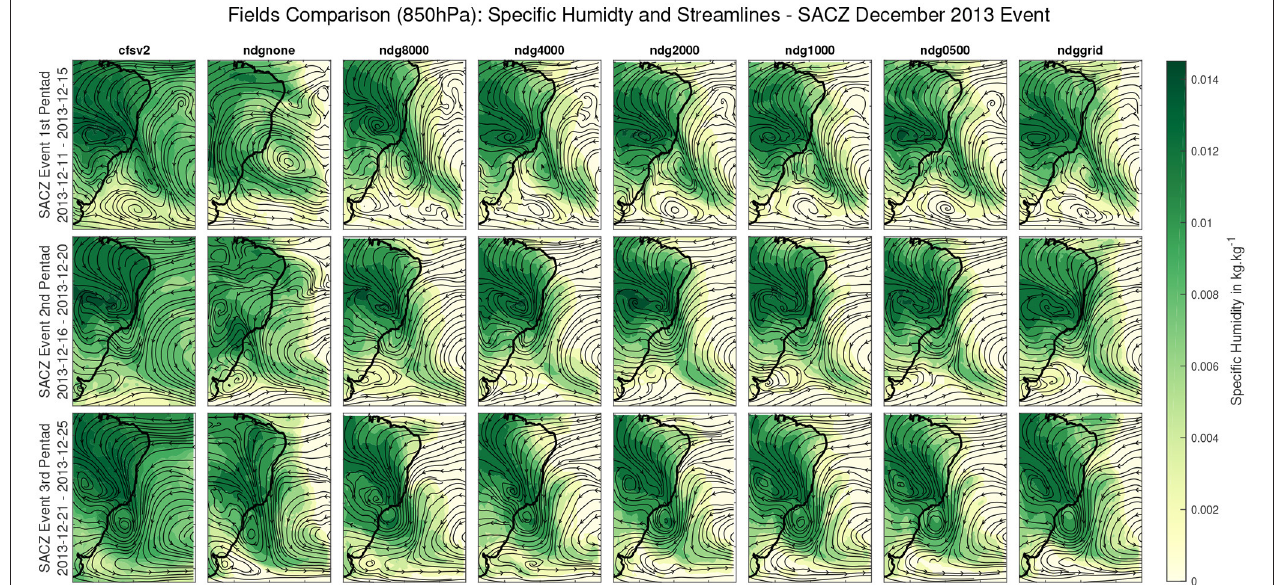
FIGURE 2 | Specific humidity (filled contours, in kg/kg) and streamlines at 850 hPa. Top, middle and bottom rows show averages calculated for the first, second and third pentads of the SACZ event, respectively.